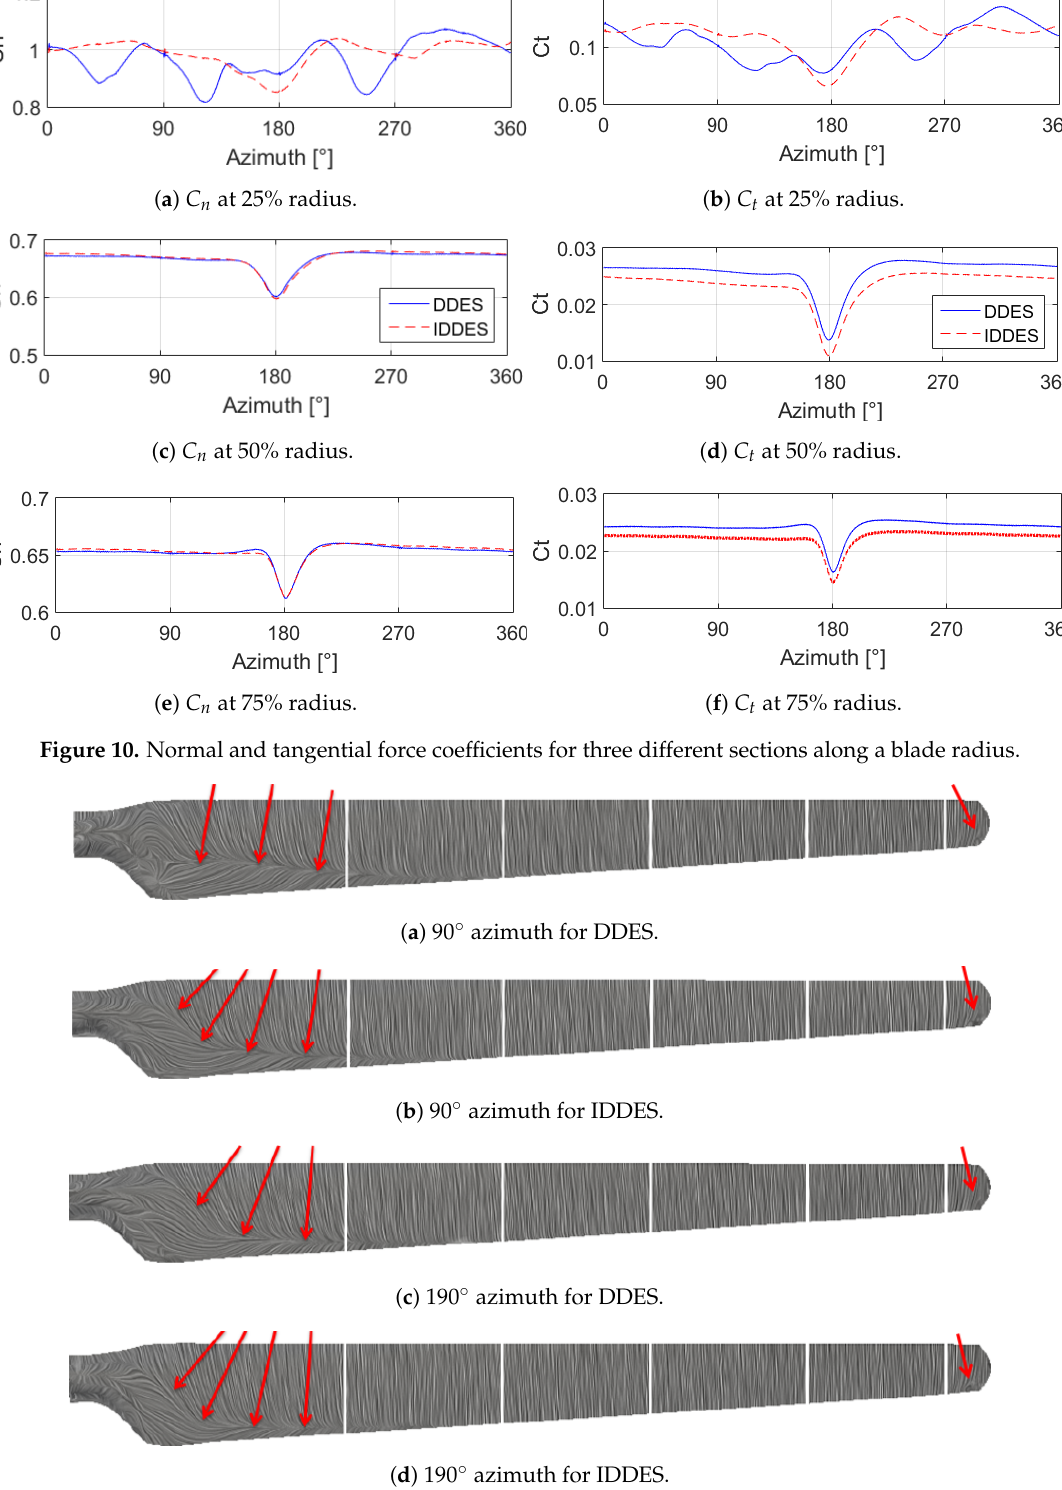
Figure 11. Comparison of wall shear stress between Improved DDES and DDES for one blade, at two different azimuthal positions. The five vertical lines indicate the location of the 30%, 47%, 63%, 80% and 95%